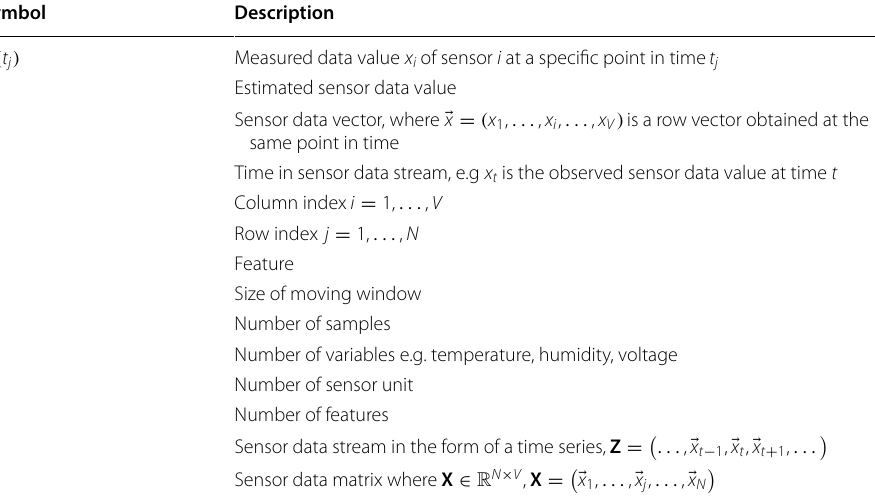
Table 1 Nomenclature used for “Methods for detecting and quantifying errors in sensor data”,“Methods for correcting errors in sensor data” and “Methods for detecting and correcting errors in sensor data” sections